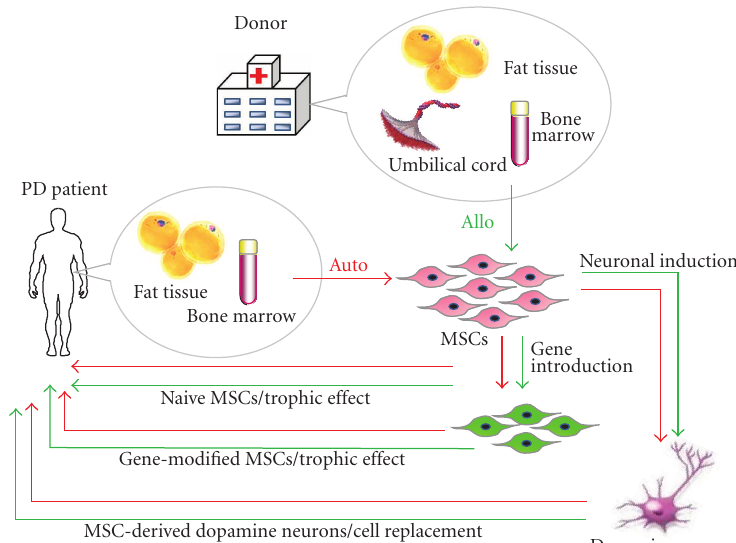
Figure 1: Strategy for MSC transplantation in PD patients. MSCs can be obtained from fat tissue or bone marrow aspirates of Parkinson’s disease (PD) patients and are applicable for autocell transplantation. They can also be obtained from fat tissue, bone marrow aspirates, and umbilical cord of healthy donors for allocell transplantation. Naive MSCs can be directly transplanted into the striatum of PD patients, but this treatment exerts temporary trophic e ff ects. Gene-introduced MSCs also have trophic e ff ects for the replenishment of lost cells. MSCs are able to be induced into dopamine neurons that will contribute to the functional recovery of PD >